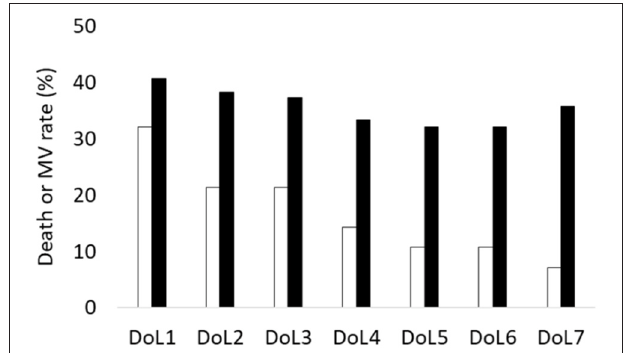
FIGURE 1 | Daily combined death or mechanical ventilation (death or MV) rate in the first week of life between LowVitD status and SufficientVitD status infants. During the first week of life, the rate of the combined outcome of death or MV need were high in infants with low vitamin D levels < 75 nmol/L (black bars).